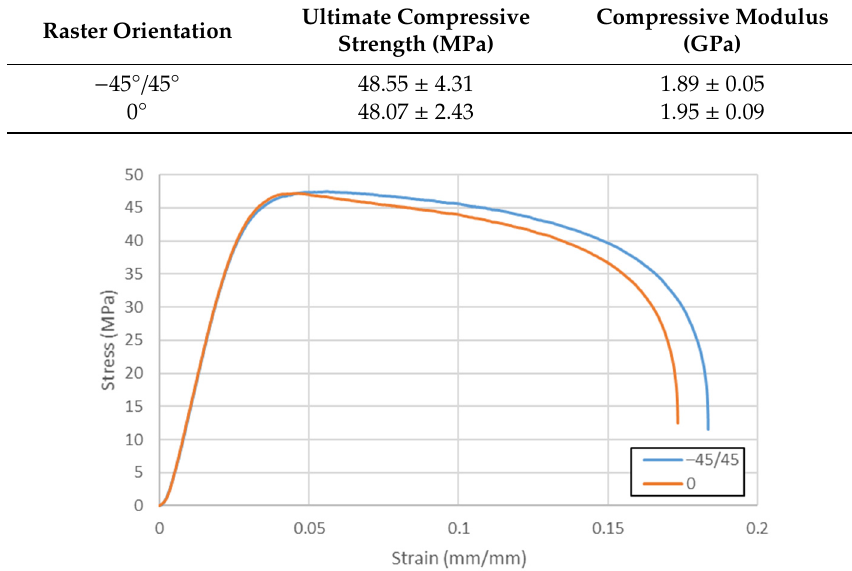
Table 4. Compression Testing Results.